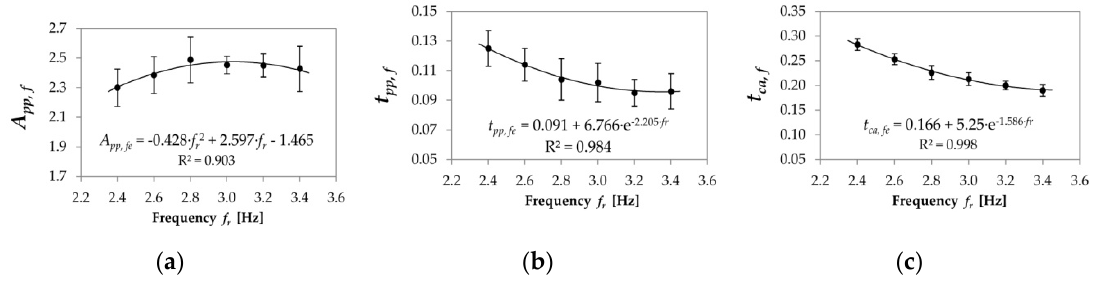
Figure 4. The F VGRF curve indicators for forefoot-strike running style: (a) indicator A pp,f , (b) indicator t pp,f , (c) indicator t ca,f .